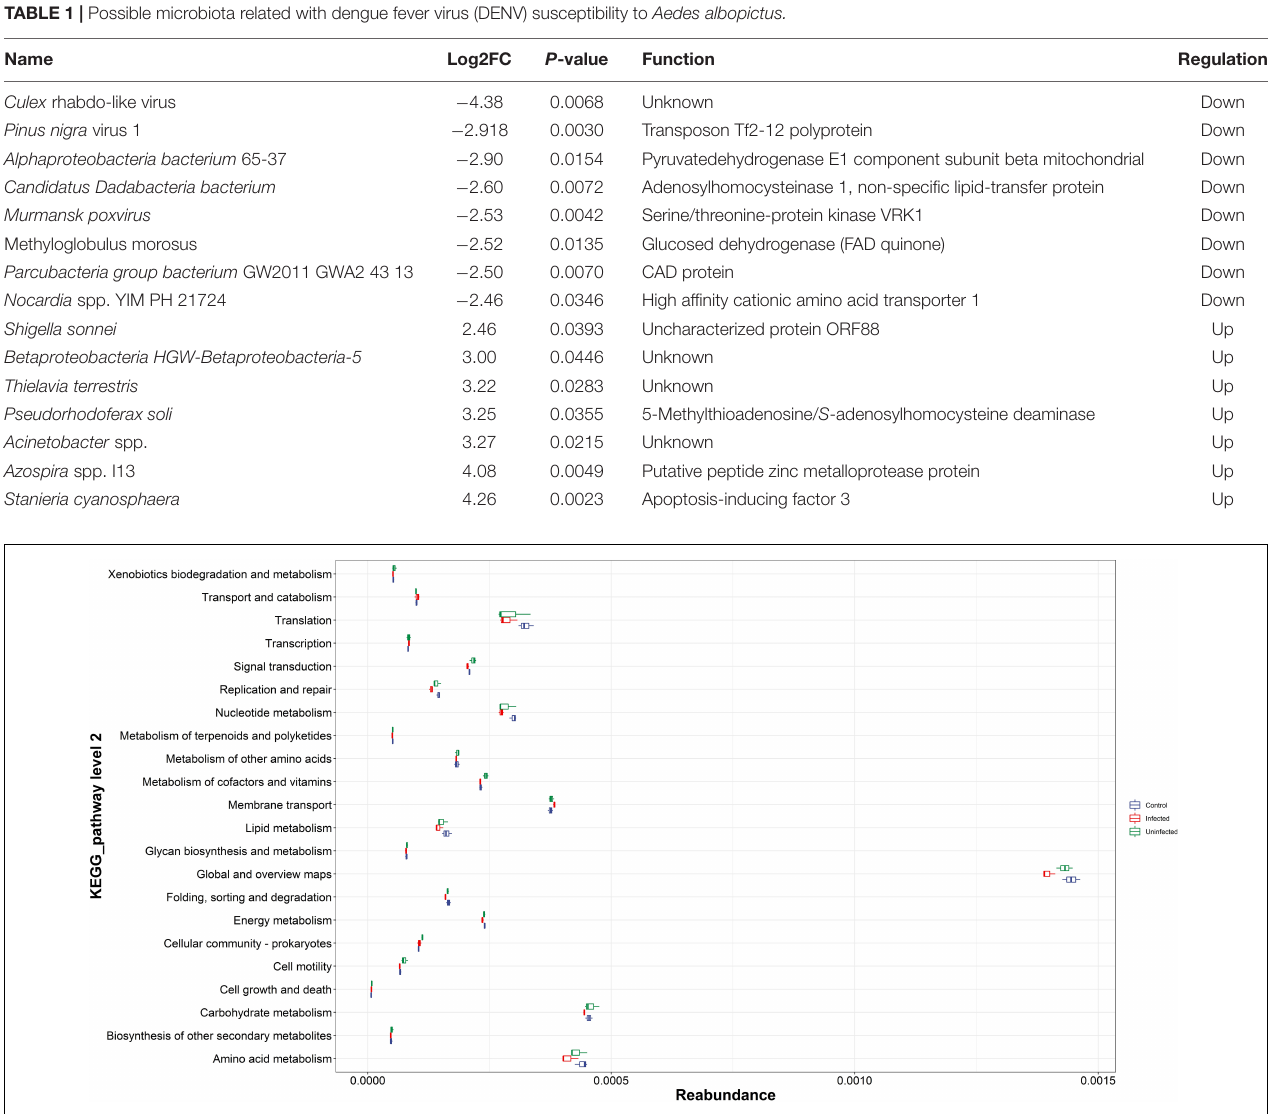
FIGURE 3 | The Kyoto Encyclopedia of Genes and Genomes (KEGG) pathway abundance map. The vertical coordinates were the KEGG metabolic pathway or secondary metabolic pathway level classification; the horizontal coordinates were the relative content of the corresponding functional gene